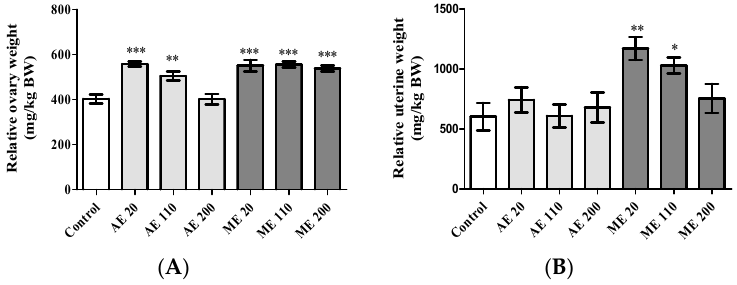
Figure 2. Relative weight of ovaries ( A ) and uteri ( B ) following treatments. Control = Animals receiving vehicle (distilled water, 10 mL/kg BW); AE = animals treated with the aqueous extract of M. arboreus ; ME = animals treated with the methanol extract of M. arboreus . Results are shown as the mean ± SEM; *: p < 0.05; **: p < 0.01; ***: p < 0.001 in reference to control.